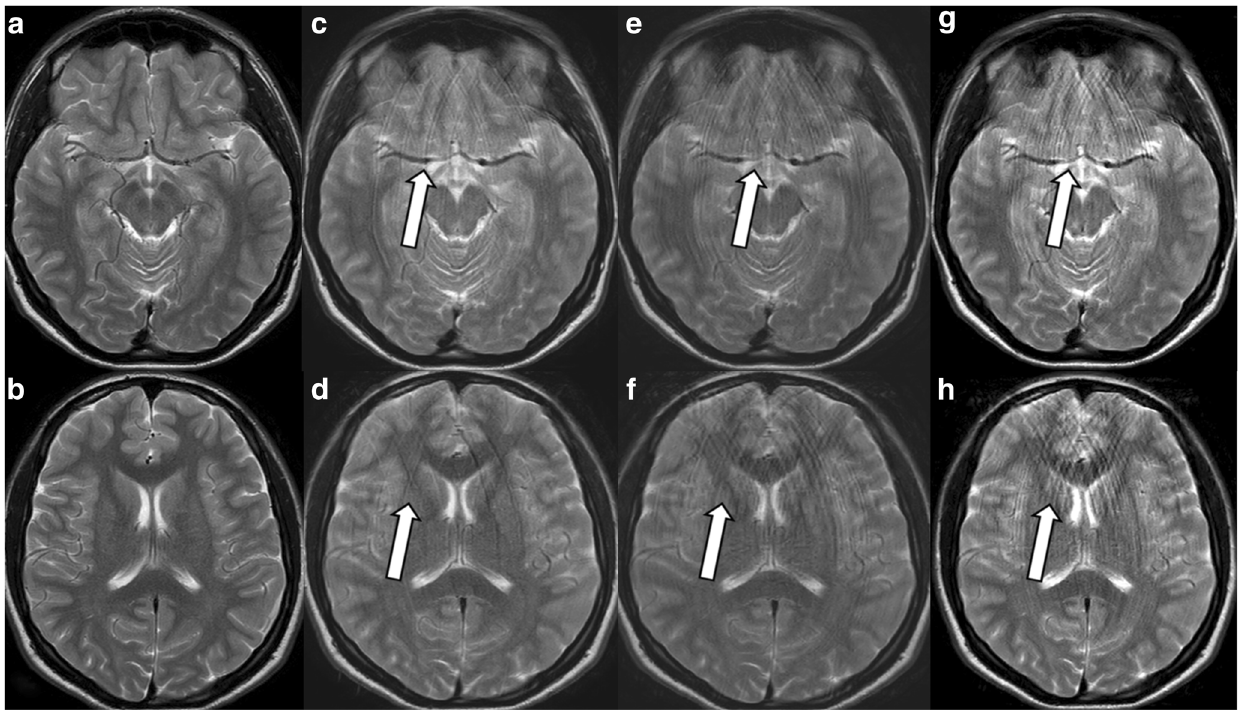
Fig. 1 Motion artefacts on images acquired with or without CS SENSE. A transverse 2D T2 TSE sequence was acquired; without Compressed SENSE ( a - d ) and with Compressed SENSE Factor 2 in Fig. 1e, h. In a and b , the volunteer did not move. In c and d , slight head movements from left to right were performed. Motion artefacts visible as semi-